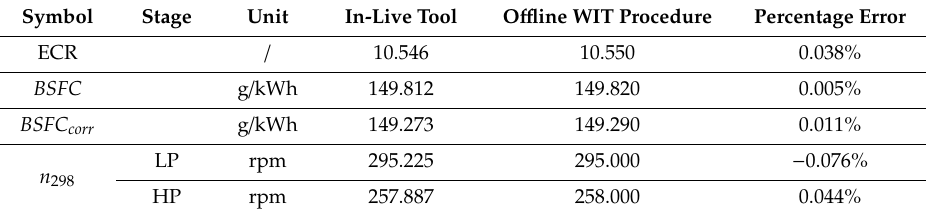
Table 6. Comparison between the output values–Running parameters. BSFC: Brake-Specific Fuel Consumption, WIT: Wärtsilä